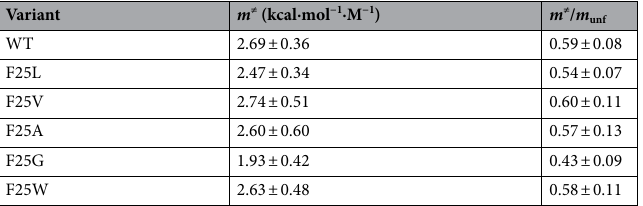
Table 3. Degree of structural unfolding in the transition state for the irreversible denaturation of hPGK1 variants determined by DSC. m ≠ values were determined from DSC experiments and Eq. (5). m unf is the theoretical value (4.54 kcal mol −1 M −1 ) for the full unfolding of the protein 29 based on a protein size of 417 residues 42